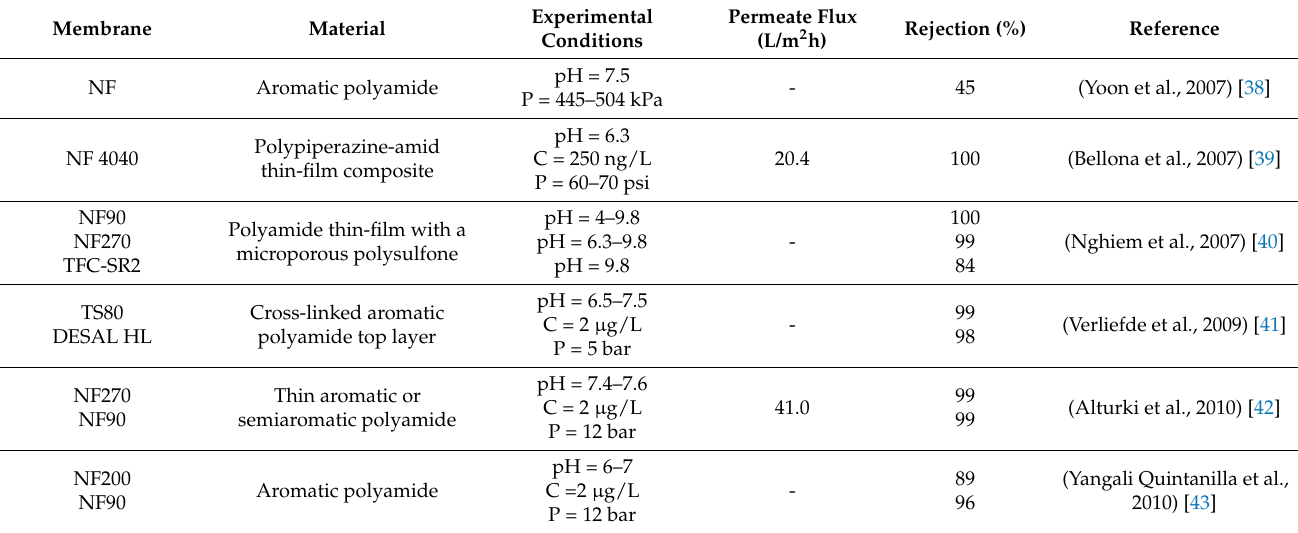
Table 3. Comparison of membrane performance in the removal of